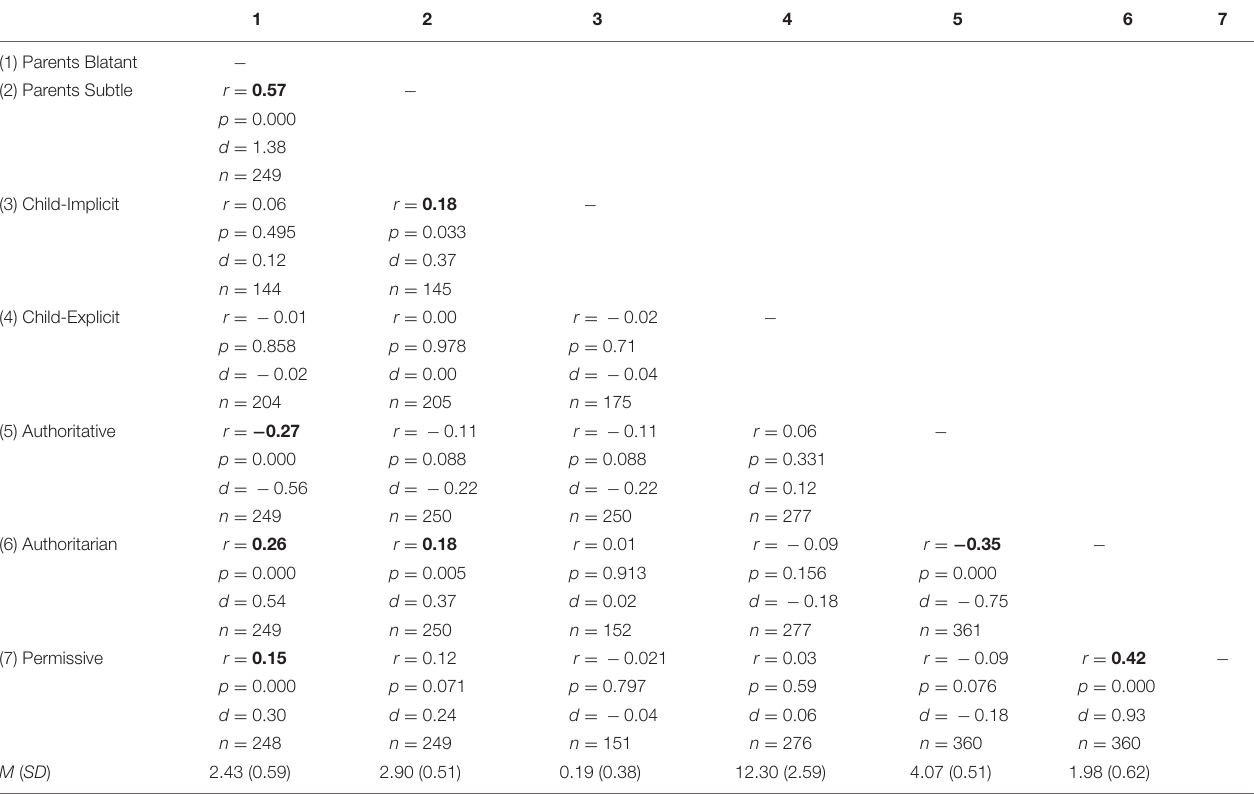
TABLE 1 | Means, standard deviations, bivariate correlations, and Cohen’s d .